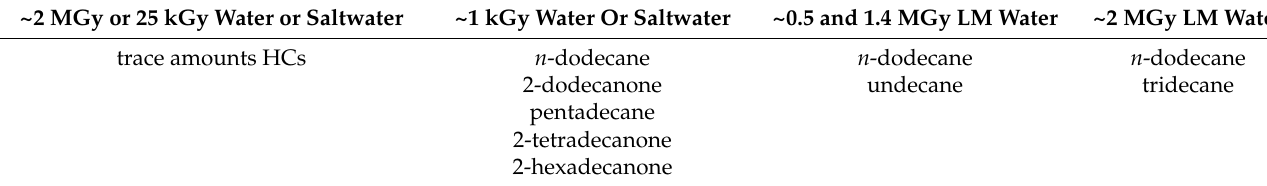
Table 2. Compounds detected after gamma irradiation using heat-treated PE stock in Milli-Q water or salt water, or Lake Michigan (LM) water. (HCs =